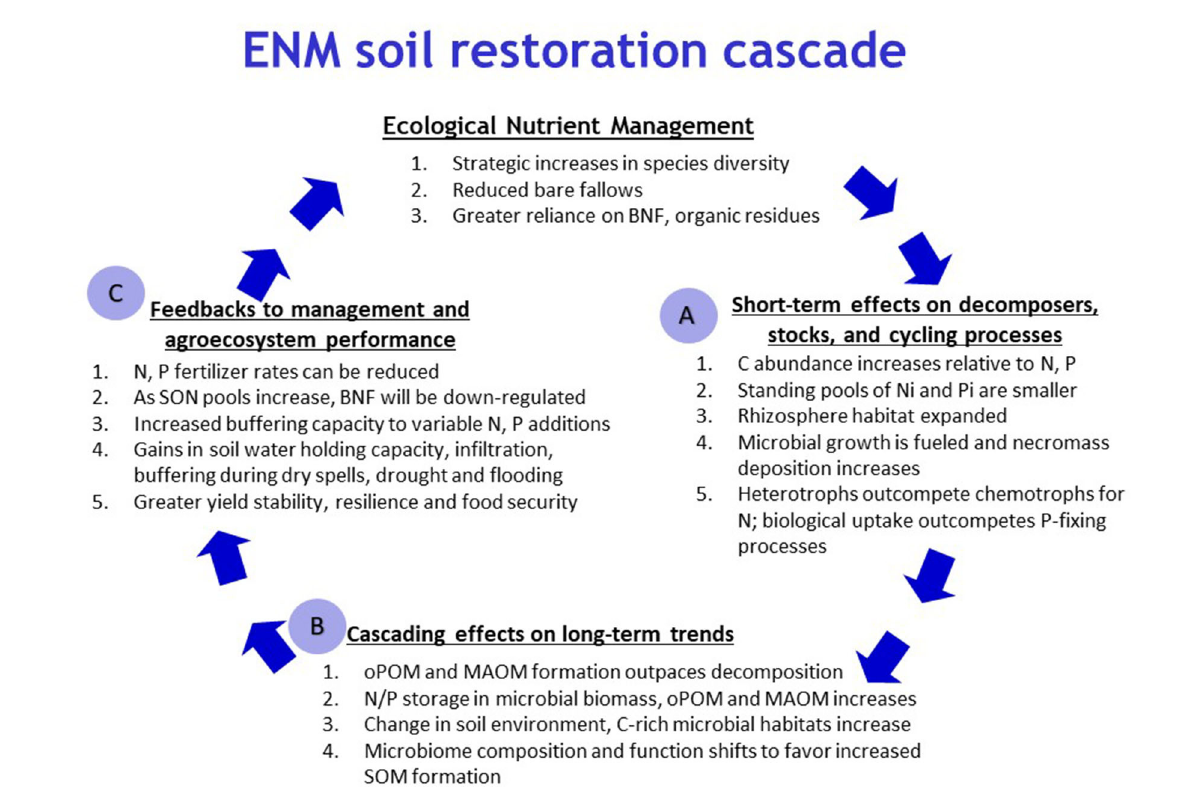
FIGURE4 ENM shifts soil processes to favor a positive trajectory of SOM accrual and soil restoration. The diagram depicts changes resulting from implementation of ENM in a degraded soil with a history of inadequate F i additions and meager returns of senescent crop residues, a situation commonly found in limited resource, smallholder systems. In the short term, cycling processes and microbial communities are altered to favor conservation pathways (A) which have cascading effects on SOM accrual, nutrient retention, and microbial community composition/function (B) and lead to feedbacks that ultimately impact yields, yield stability/resilience and management (C) . BNF, biological N